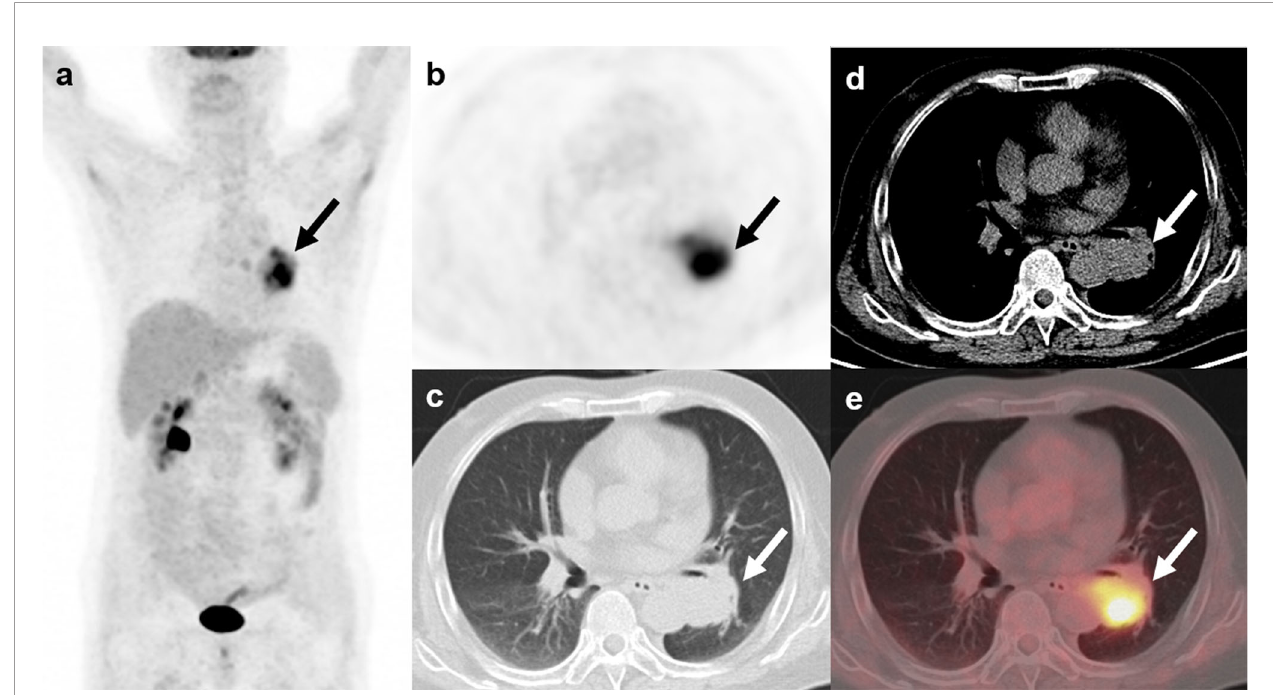
FIGURE 7 | 18 F-FDG PET/CT fi ndings in a representative case of small cell lung cancer (Patient, 24). A 57-year-old man diagnosed with ectopic Cushing syndrome underwent 18 F-FDG PET/CT to localize the source of ACTH secretion. PET/CT images demonstrate a highly FDG-avid mass ( A – E ; arrows; SUV max , 7.7) adjacent to the left hilum. The mass was then surgically removed and postoperative histopathology con fi rmed small cell lung cancer with ACTH positivity in